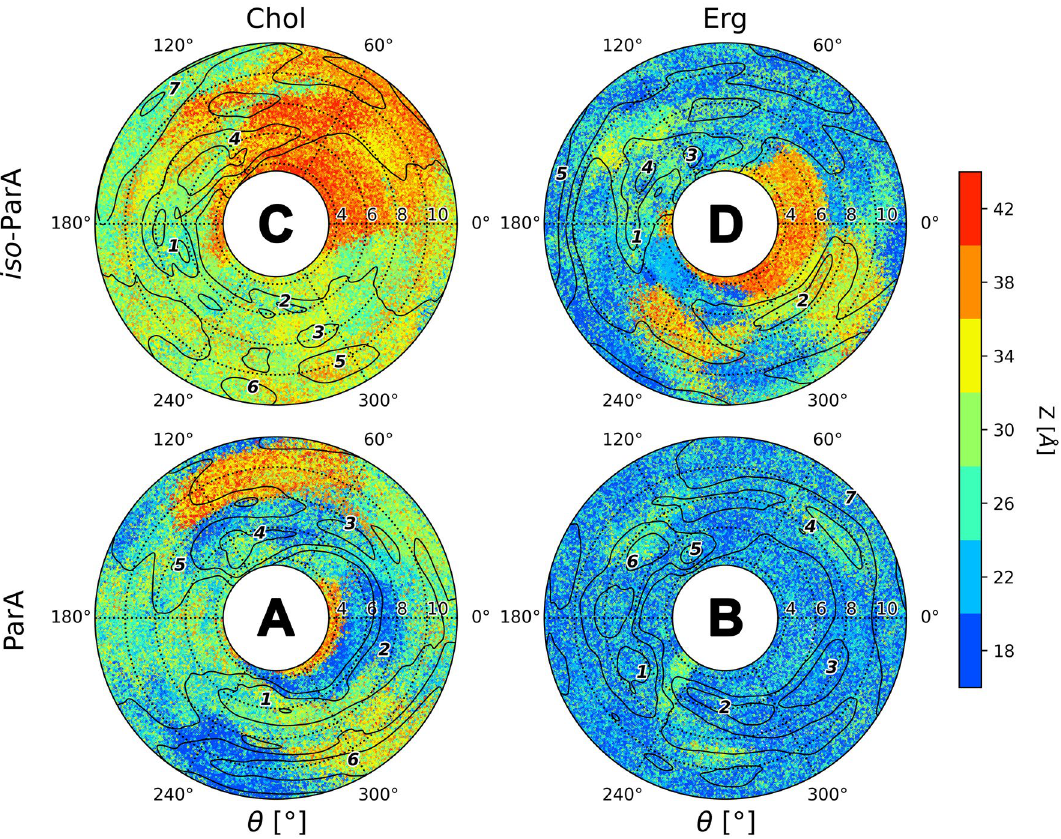
Figure 8. Interactions of partricin’s A ( A & B ) and iso-partricin’s A ( C & D ) side chain with an opposite leaflet of a lipid